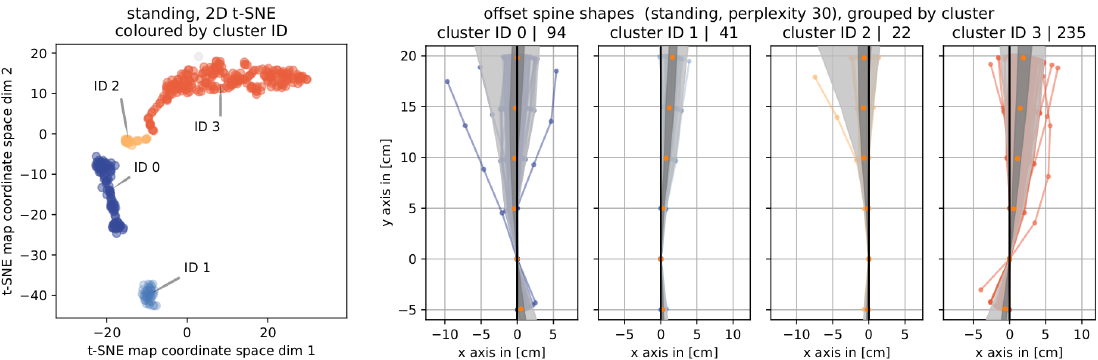
Figure 7. Results for clustering posture pairs of standing . ( left ) The T-SNE map labelled with and colored by cluster ID. ( right ) Corresponding cluster bundles of offset spine shapes including information about the cluster ID and the number of elements in that cluster in each axis title.